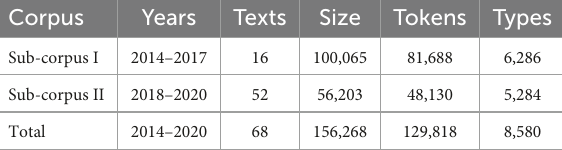
TABLE 2 The corpus: CI-related texts on NAS’s official website from 2014 to 2020.